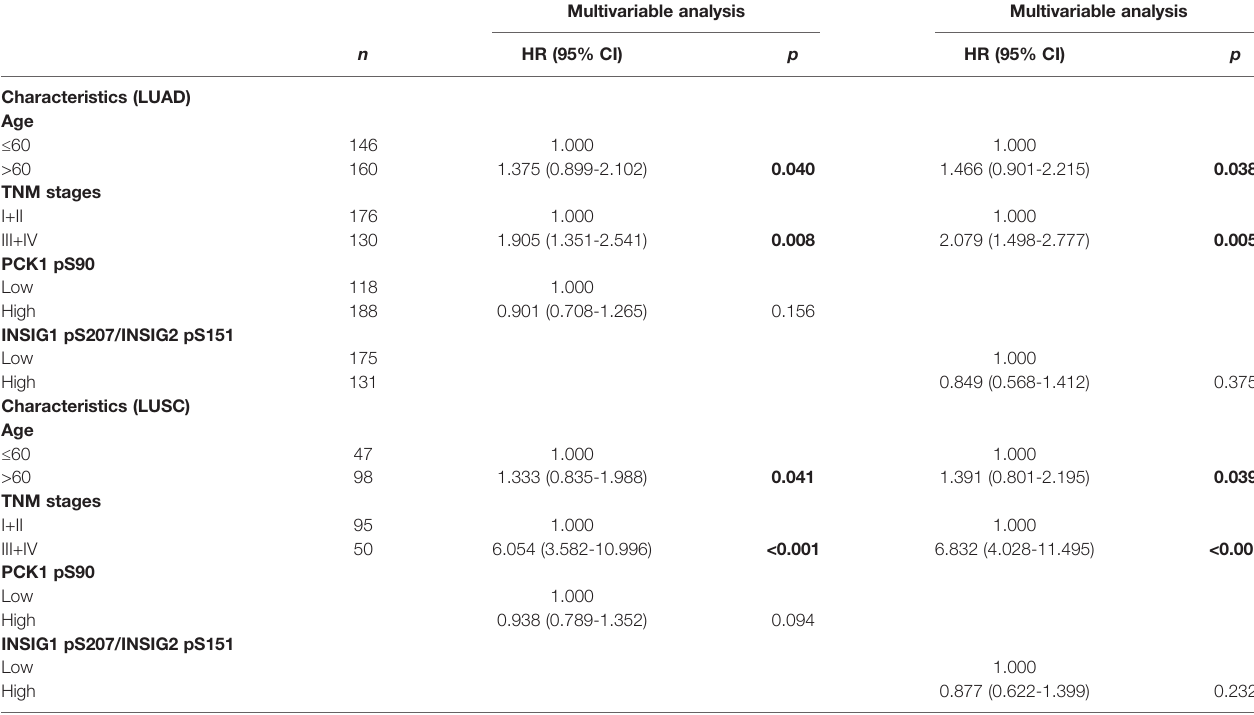
TABLE 3 | Multivariable overall survival analysis in patients with LUAD and